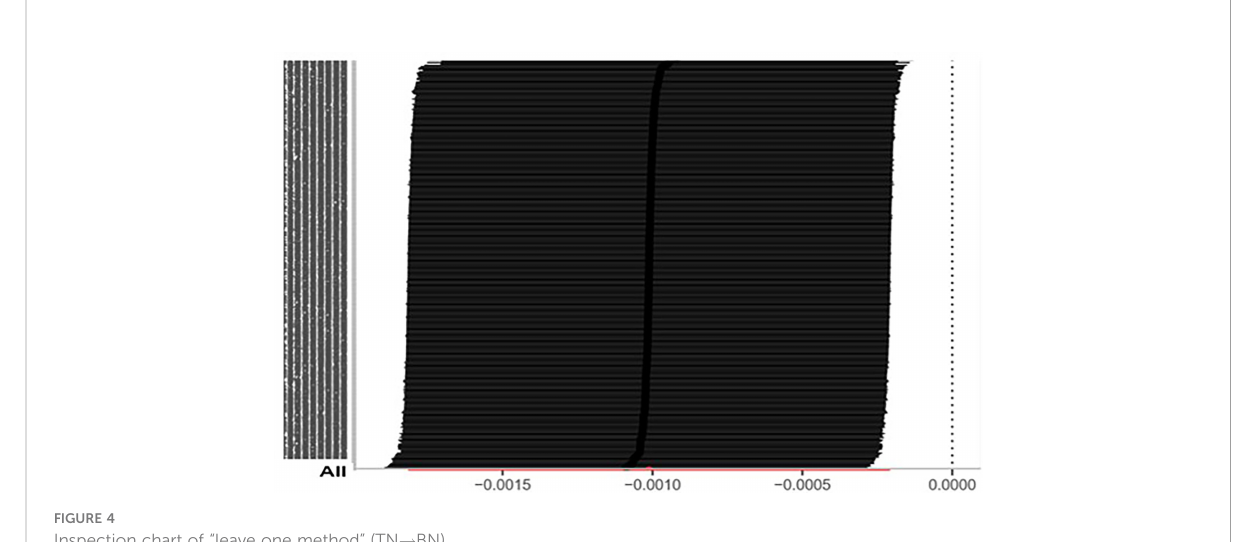
FIGURE 4 Inspection chart of “ leave one method ” (TN !